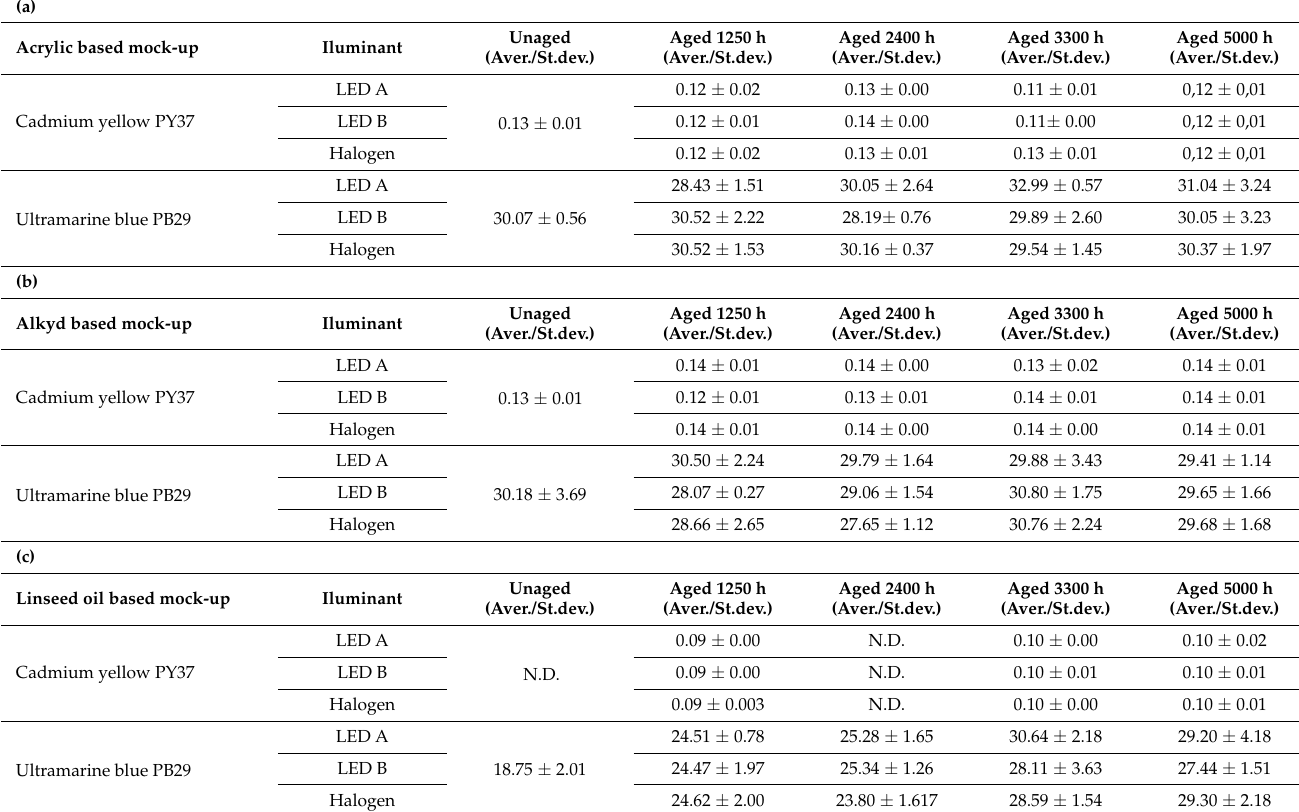
Table 4. µ -Raman band area ratios in % (average—Aver., and standard deviation—St. Dev.) among CdS 2LO (600 cm − 1 )/CdS 1LO (300 cm − 1 ) for cadmium yellow PY37 and S 3 − (552 cm − 1 )/S 2 − (590 cm − 1 ) for ultramarine blue PB29 based ( a ) acrylic, ( b ) alkyd, and ( c ) linseed oil mock-ups, at different ageing times (h = hours) and under different illuminants (LED A: 420 nm, LED B: 460 nm, and Halogen: halogen lamp). N.D = Not